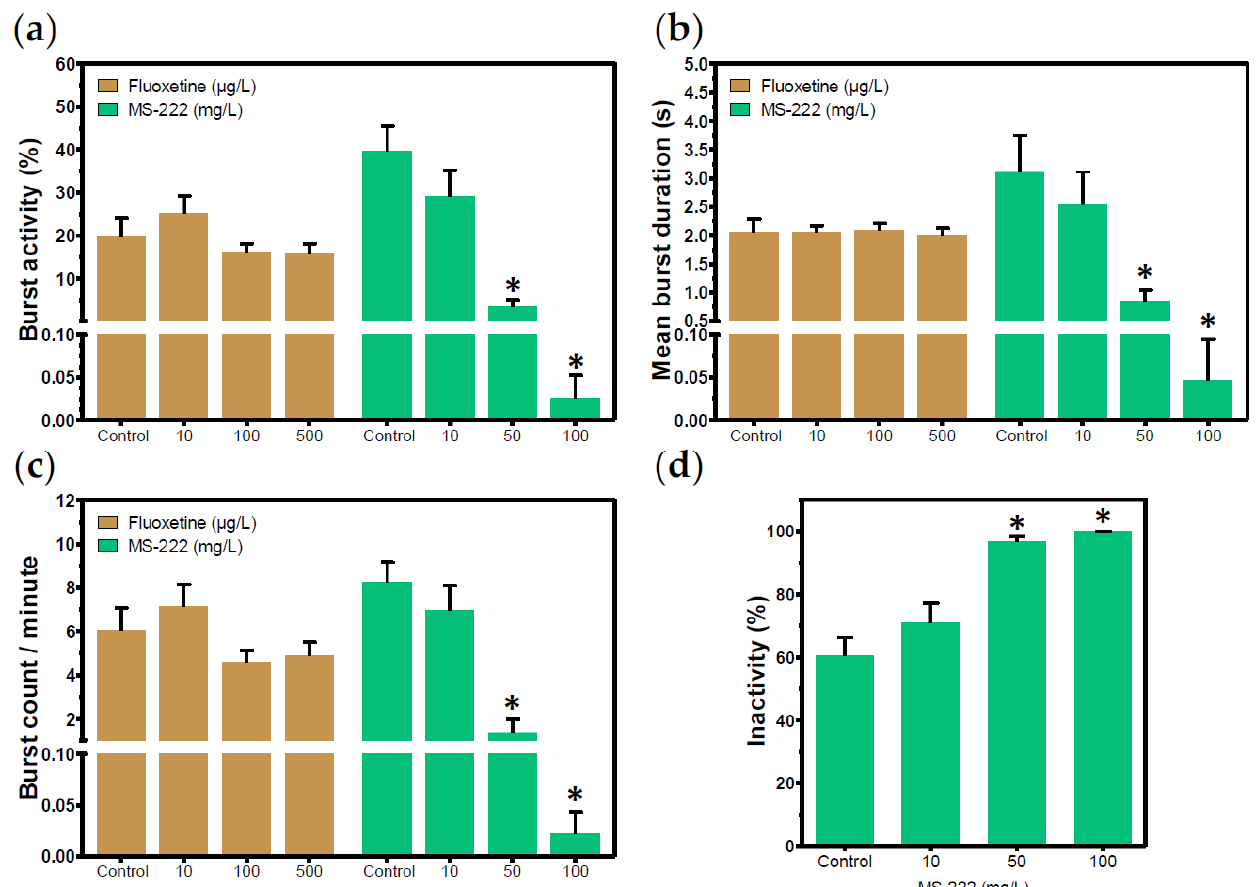
Figure 5. Coiling activity of zebrafish ( Danio rerio ) embryos aged 26.0–28.5 hours post-fertilization (hpf) following exposure to positive control candidates for hypoactivity. ( a ) Percentage (%) of burst activity; ( b ) mean burst duration (seconds); ( c ) burst count per minute; ( d ) percentage (%) of inactivity. Significant differences between control (embryo medium or 0.01% dimethyl-sulfoxide (DMSO)) and treatments were tested by ANOVA on ranks (Kruskal–Wallis test), followed by the Dunn’s post-hoc test (* p ≤ 0.05); n = 60 embryos per treatment, divided into three independent experiments. Values are expressed as means (bars) and 95% confidence intervals (error bars).